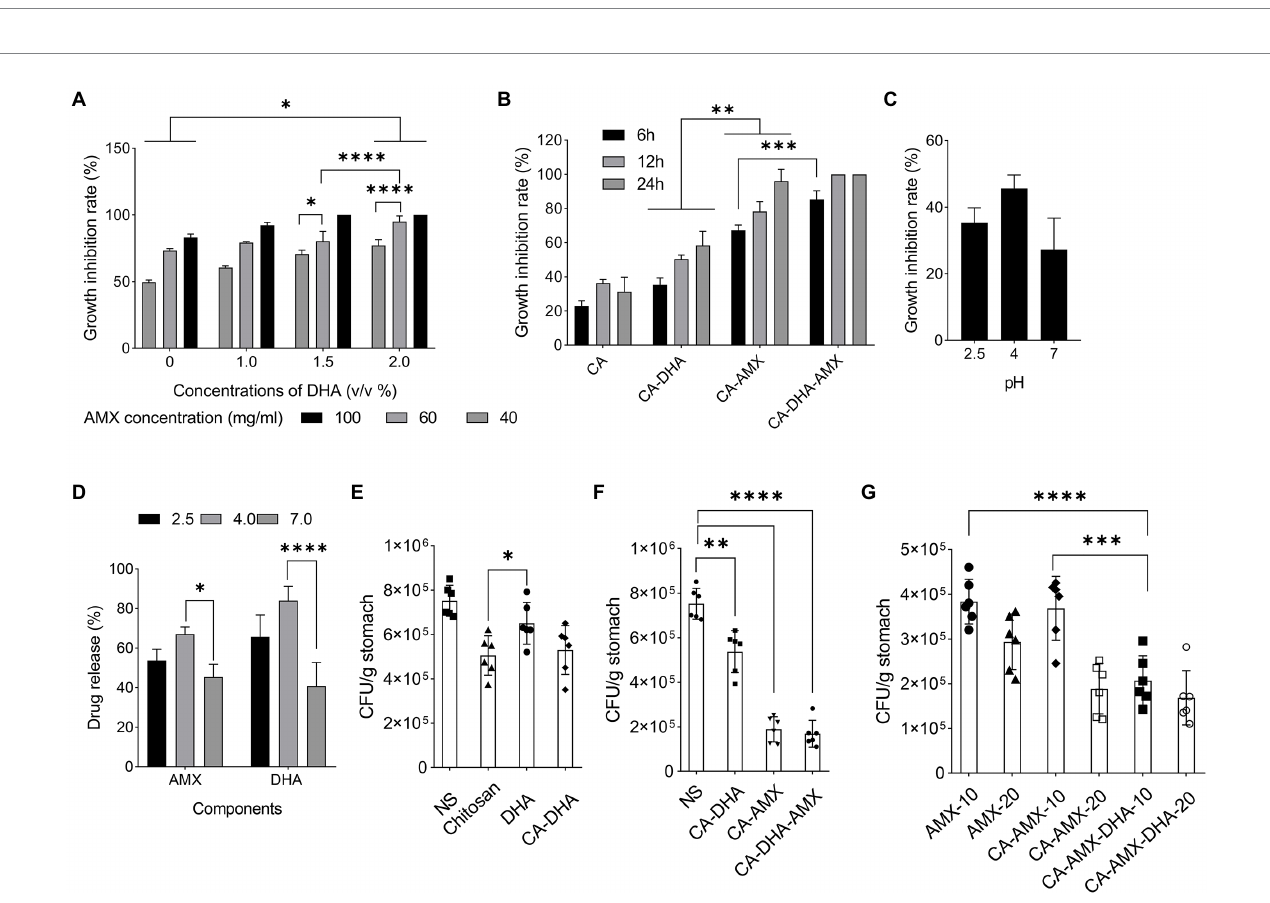
FIGURE 3 The growth inhibition activity of composite NPs. (A) The antibacterial activity of CA-NPs containing different concentrations of DHA and AMX. (B) The growth inhibition rate of CA-DHA (100 μ M)-AMX (60 mg/ml) composite NPs at different time intervals 6, 12, and 24 h. (C,D) CA-DHA (100 μ M)-AMX (60 mg/ ml) at different pH values after 6 h incubation was investigated for their growth inhibition activity and release of drugs. (E) The in vivo antibacterial activity of chitosan, DHA and CA-DHA. (F) In vivo antibacterial activity of various formulations of composite NPs, including CA-DHA, CA-AMX, and CA-DHA-AMX compared with the untreated group. (G) Antibacterial activity was tested at a dose of 10 and 20 mg/kg AMX in different formulations. Data are presented as mean ±